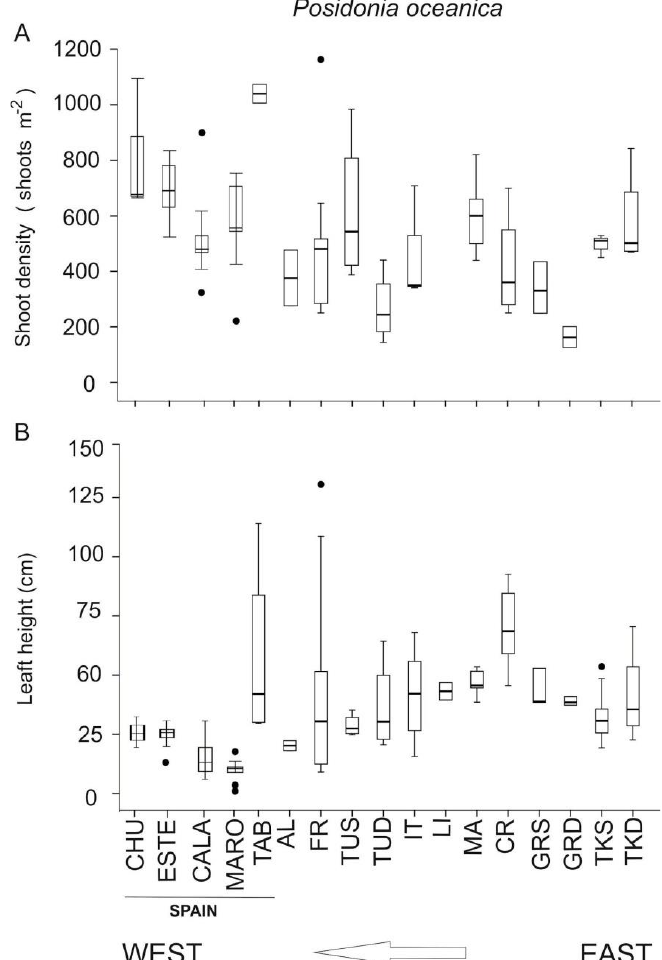
Figure 6. Shoot density ( A ) and leaf height ( B ) of Posidonia oceanica at the studied sites of the northwestern Alboran Sea (in the case of Calahonda SAC, data were clustered from different seasons and years considering Calaburras and Calahonda), as well as at other locations of the Mediterranean Sea. The bold black line in the box represents the median value. The upper and lower ends of the box represent the third (Q 3 ) and first (Q 1 ) quartiles, respectively. The ends of the lines extending vertically from the bars (whiskers) are the minimum and maximum values. Outliers are plotted as individual points. CHU, Punta Chullera; ESTE, Estepona SAC; CALA, Calahonda SAC; MARO, Maro MPA; TAB, Tabarca Island (E Spain) [32]; AL, Algeria [77]; FR, France [30,34]; TUS and TUD, Tunisian shallow (< 5m depth) and deep (> 5m) meadows, respectively [73]; IT, Italy [31,33,36]; LI, Libya [78]; MA, Malta [79]; CR, Croatia [50]; GRS and GRD, Greek shallow (< 5m) and deep (> 5m) meadows, respectively [49]; TKS and TKD, Turkish shallow (< 5m) and deep (> 5m) meadows, respectively [12].